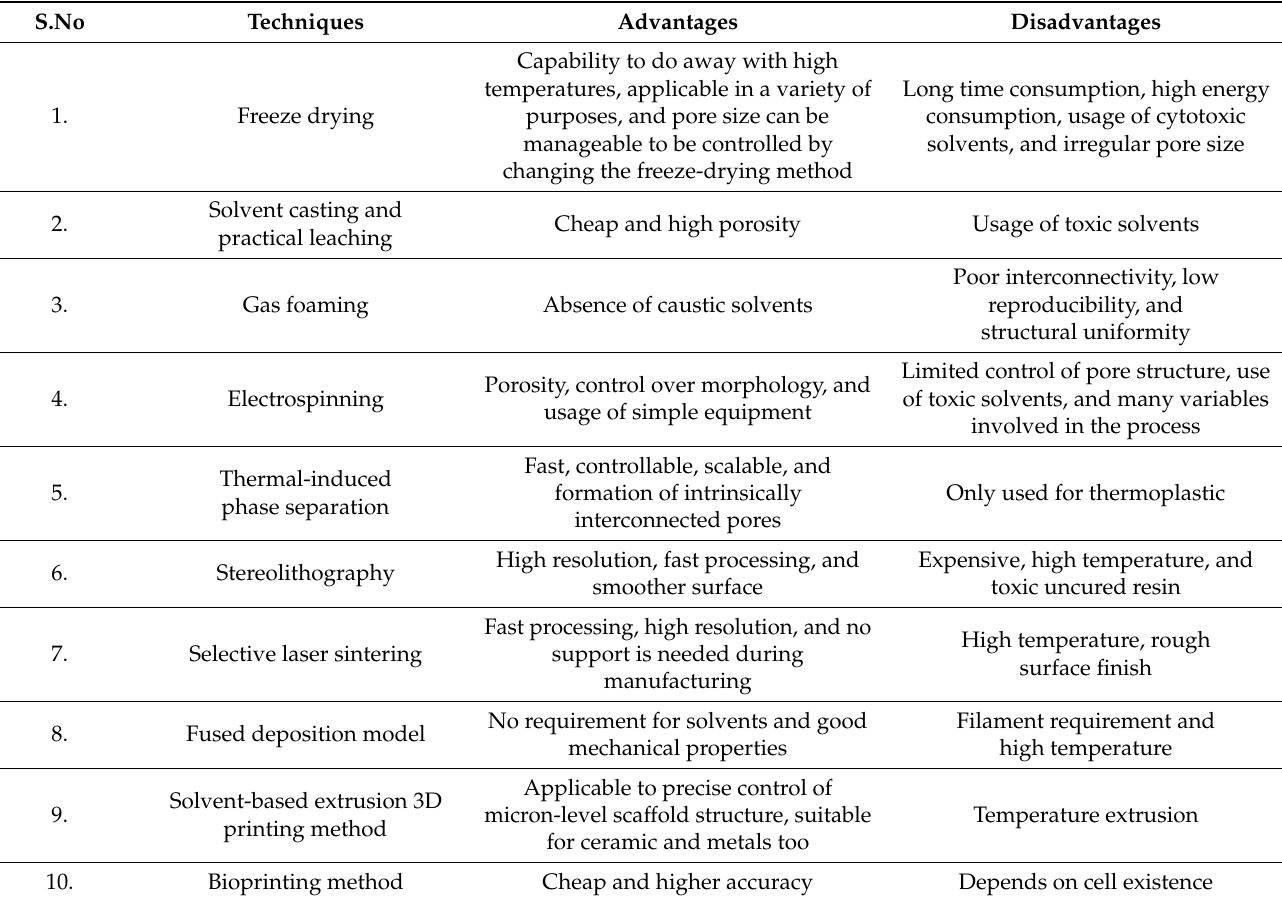
Table 5. Advantages and disadvantages of various fabrication